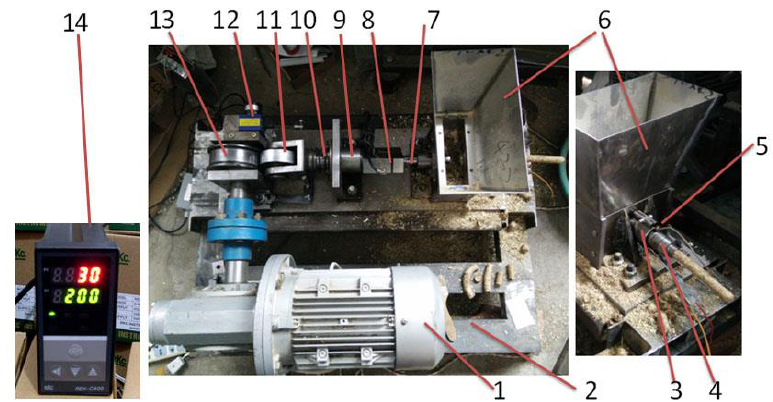
Figure 4. Mechanical structure of the self-developed extruder. 1. Reducer. 2. Frame. 3. Heating tape. 4. Cylinder die. 5. Thermocouple. 6. Hopper. 7. Piston. 8. Pressure sensor. 9. Sliding bearing. 10.